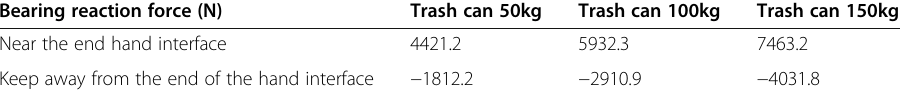
Table 7 Comparison of front and rear reaction forces at the gripper interface of the manipulator Bearing reaction force (N) Keep away from the end of the hand